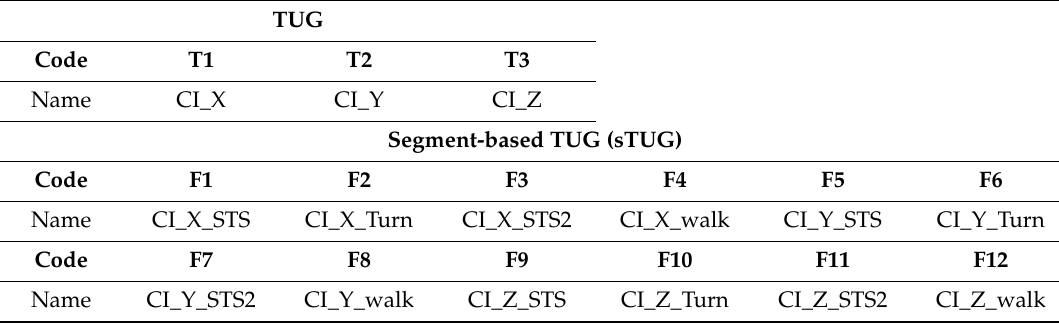
Table 1. Features used by the TUG segmentation and sub-axis with the sensors, whose descriptions are